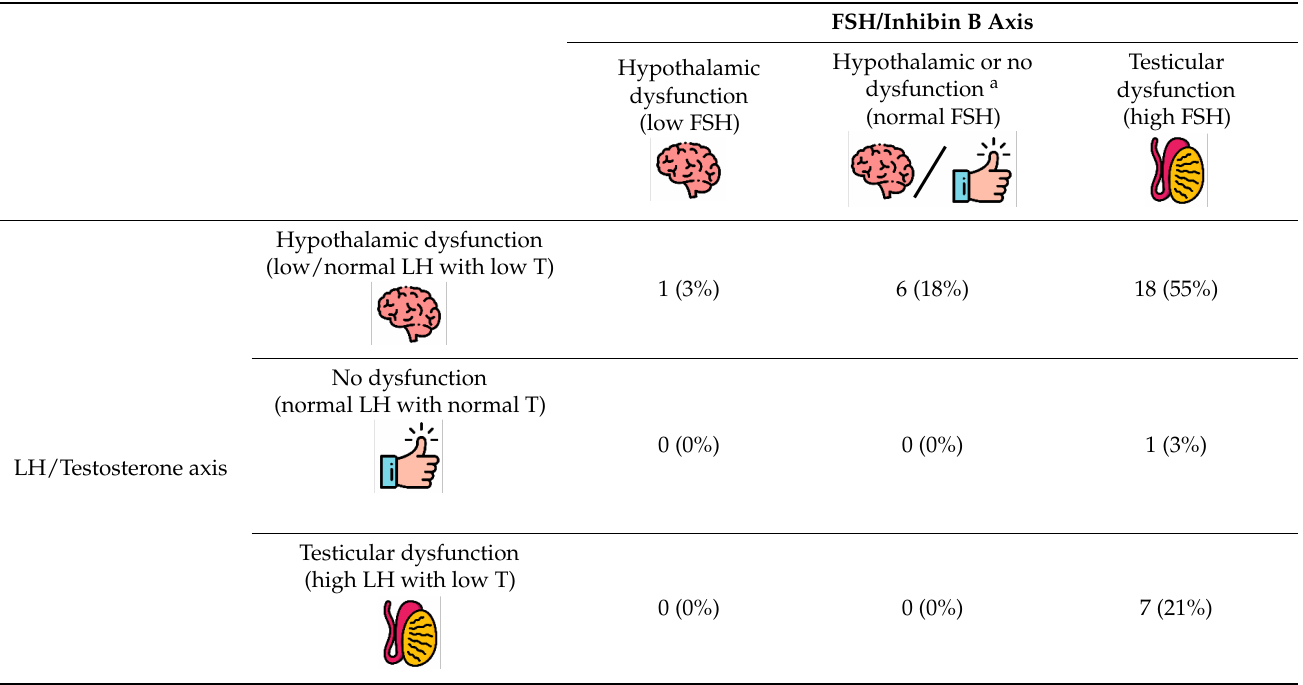
Table 4. LH and FSH values in males with